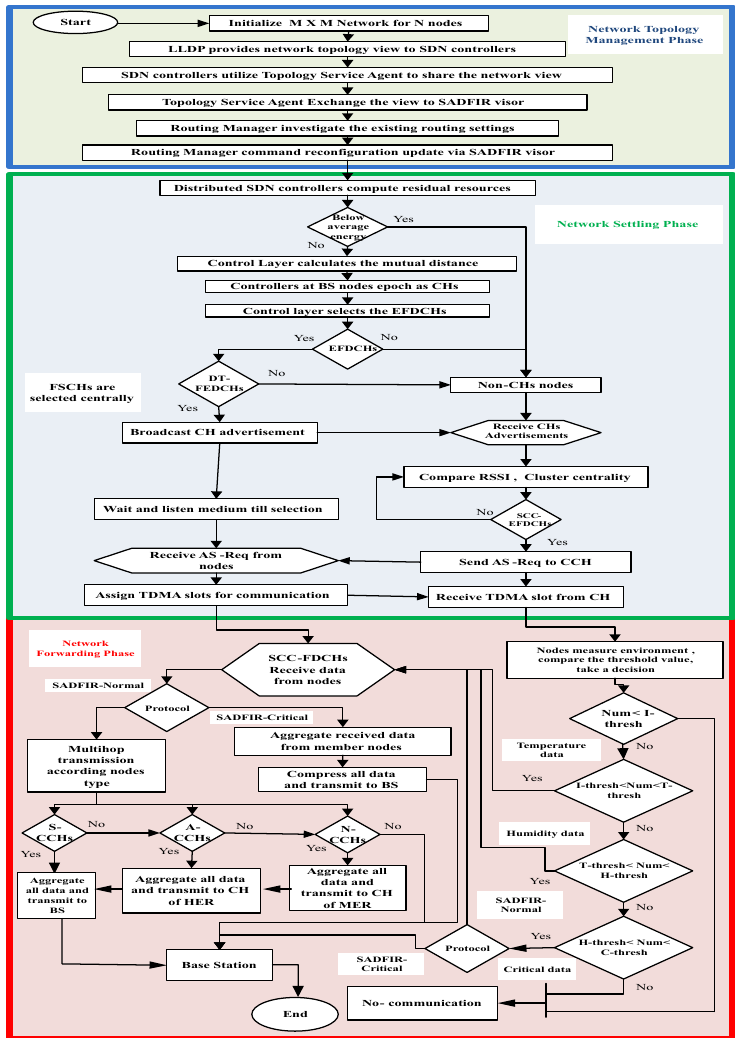
Figure 7. Flowchart of proposed